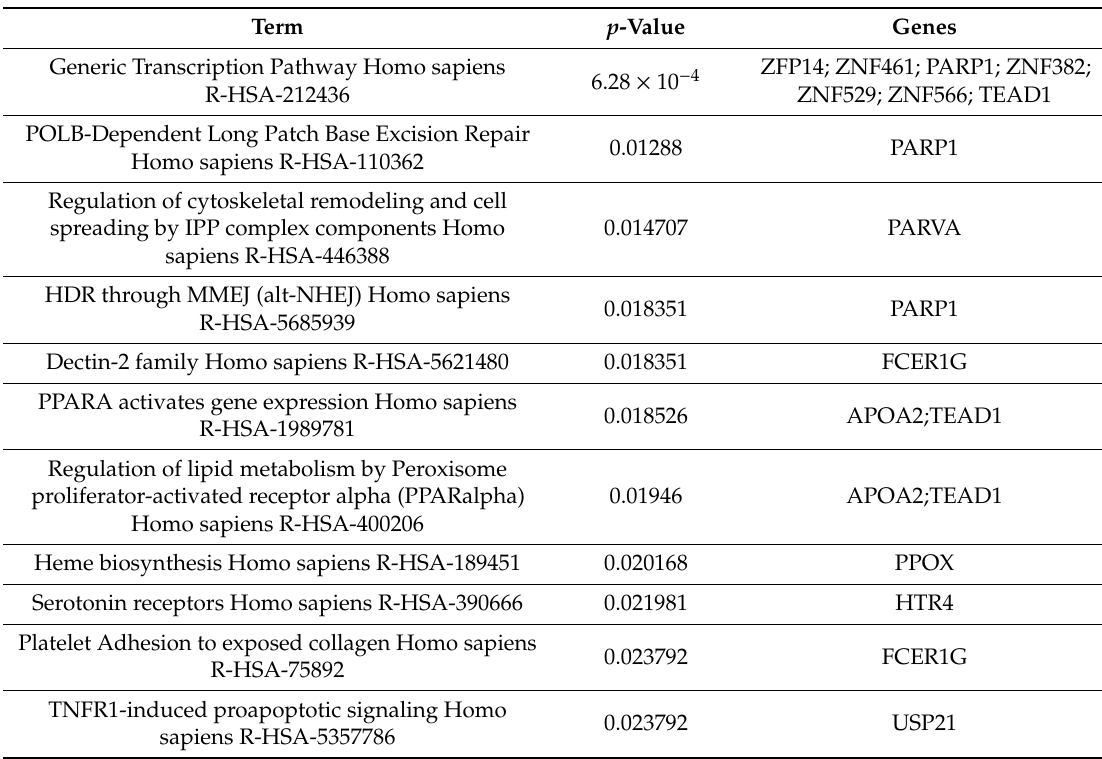
Table 4. Gene set enrichment analysis of the 37 shared amplified genes using the Reactome database found in patients 1, 3, 6, and